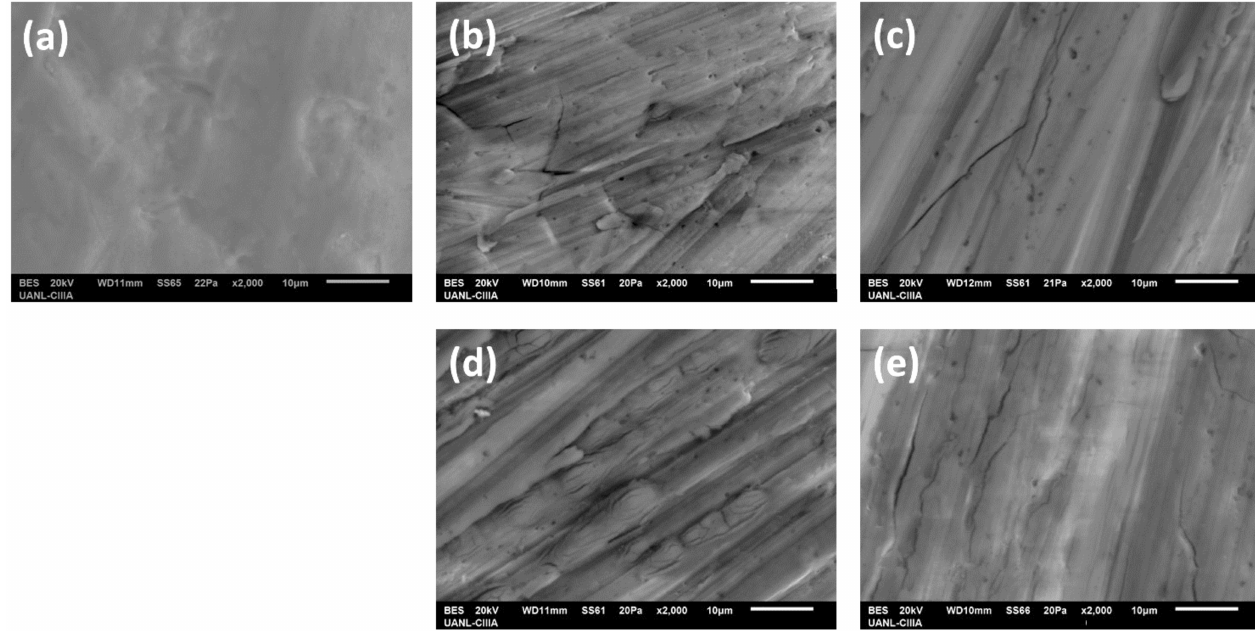
Figure 1. SEM surface morphology of the AA6061 anodized a 3 A/dm 2 in different baths: ( a ) 3A C0M S2M, ( b ) 3A C1M S5,